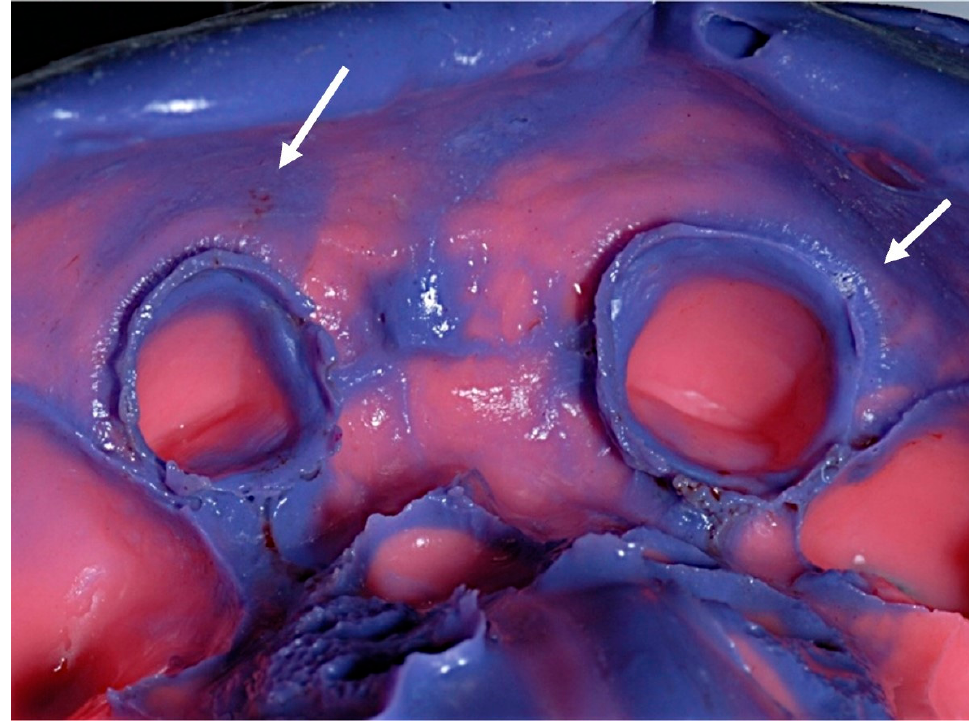
Figure 6. Debris of saliva and blood on a conventional elastomeric dental impression (arrows indi- cated).